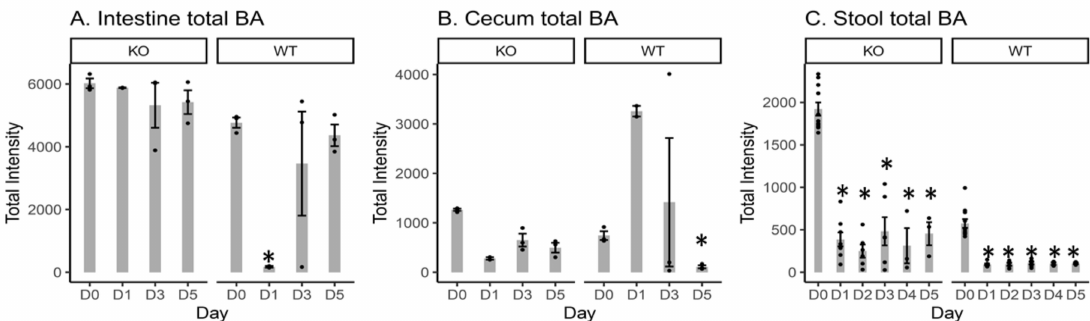
Figure 2. Bar plots of the total bile acid (BA) intensity at D0, D1, D3 and D5 in the intestinal content ( A ) and cecal content ( B ); and at D0, D1, D2, D3, D4 and D5 in the stool samples ( C ) from KO and WT mice. D0 = day 0 (prior to Cef treatment); D1, D2, D3, D4 and D5 = 1, 2, 3, 4, or 5 days after Cef treatment, respectively; * = significant changes at p < 0.05; • = intensity data from each individual